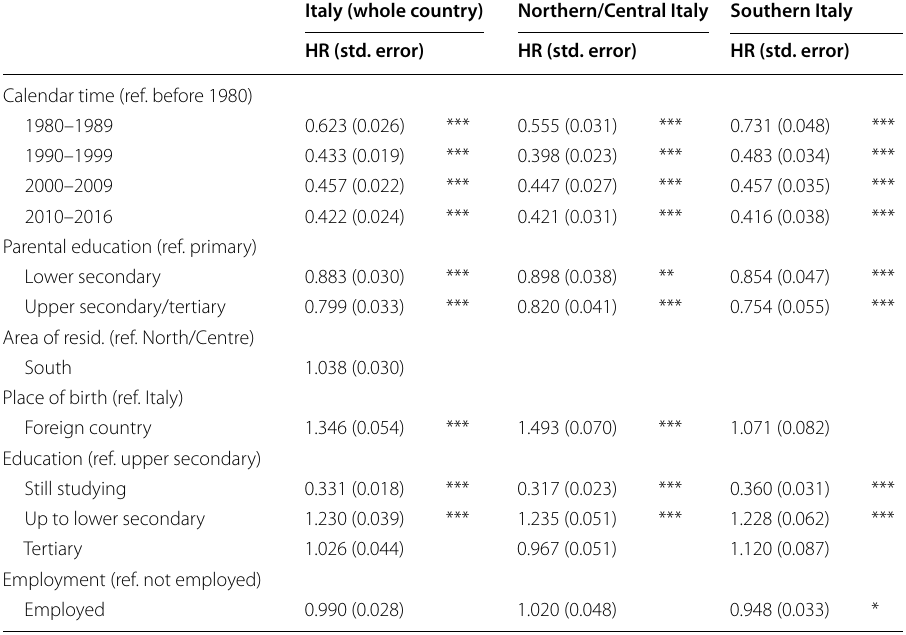
Table 4 Employment status and transition to motherhood, only women who have never worked for more than 6 months in the macro-area opposite to that they live in at the time of the interview. Cox models, HRs are reported with standard errors in brackets